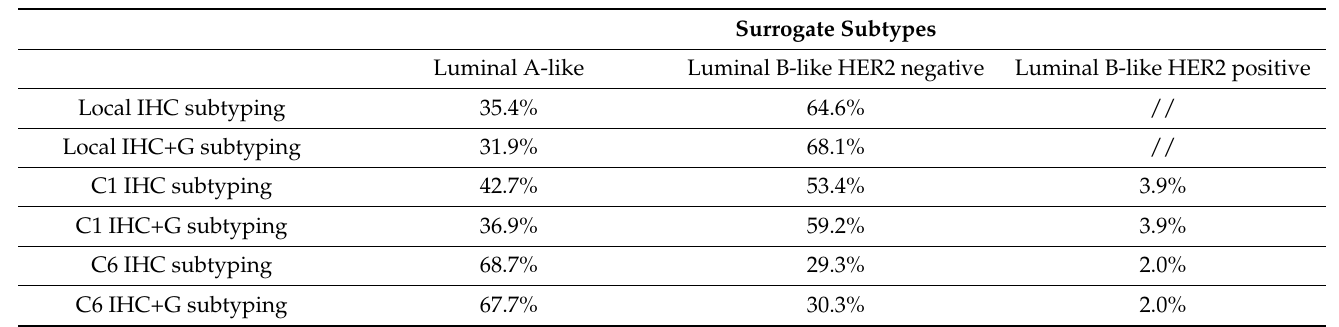
Table 1. Frequency of the different surrogate subtypes locally and centrally (C1, C6) assessed using both immunohistochemistry (IHC) and IHC+G